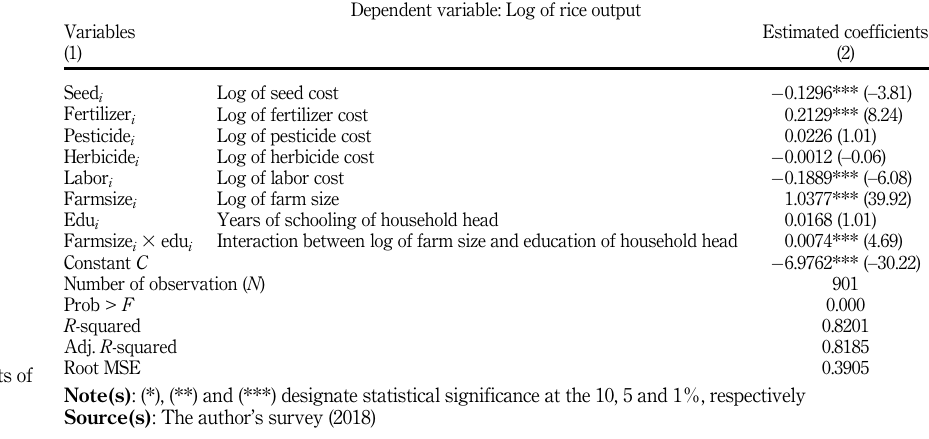
the varied coefficient